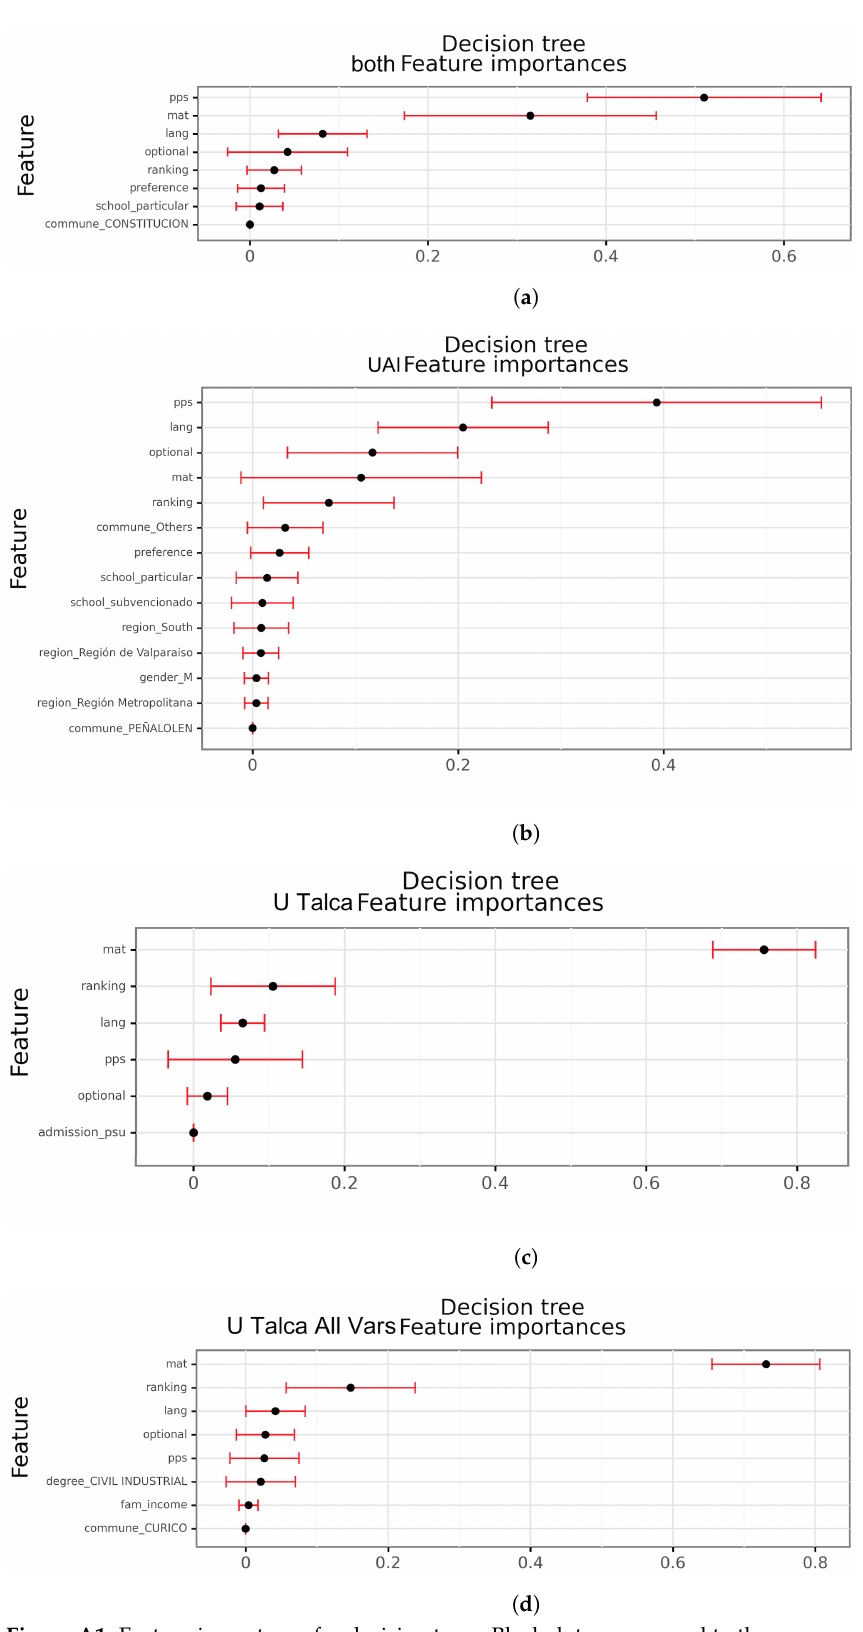
Figure A1. Feature importance for decision trees. Black dots correspond to the means, while red bars represent one standard deviation. ( a ) Both. ( b ) UAI. ( c ) U Talca. ( d ) U Talca All